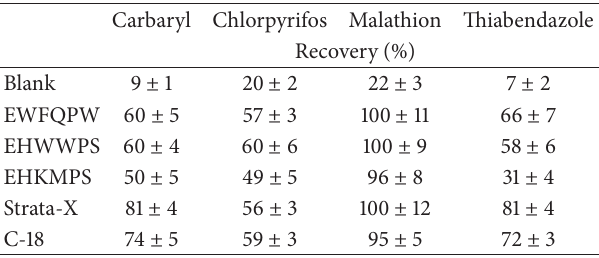
Table 2: Competitive absorption results using SPE cartridges recovery. The values are reported in percentage and were obtained using four-pesticide solution at the total concentration of 120 ppb (each pesticide at concentration of 30